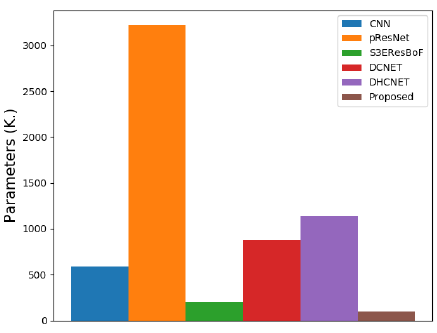
Figure 9. Trainable parameters of the models considering the image University of